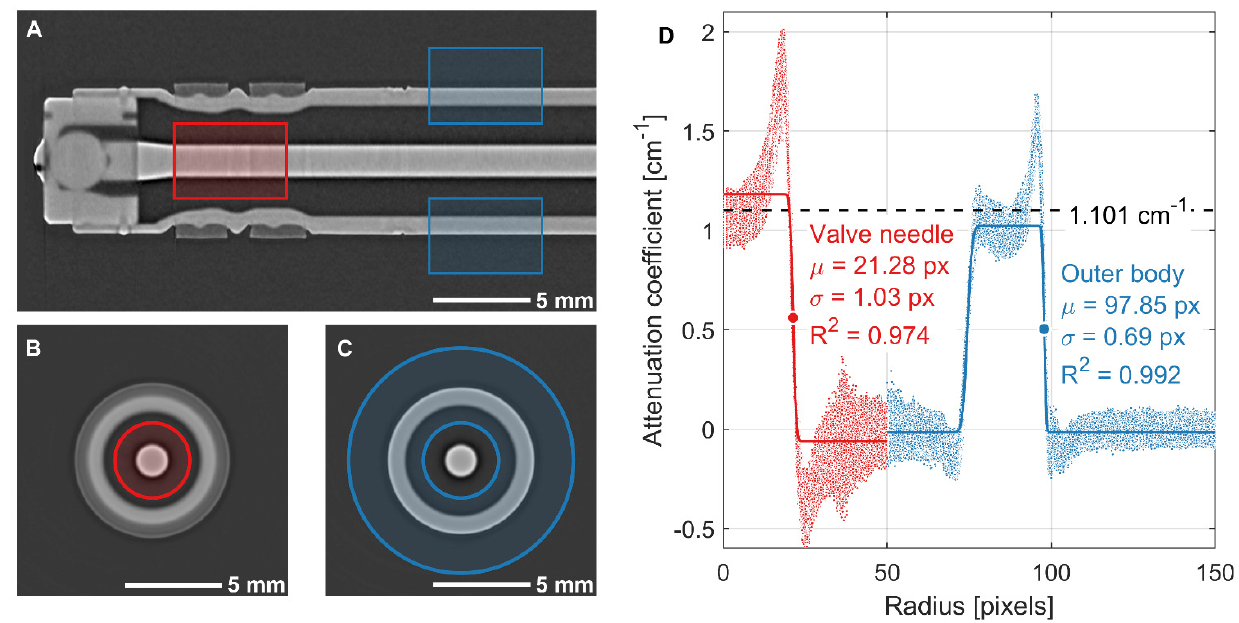
Figure 7. Process for extracting needle radius from neutron CT. Radial regions extending from the needle center were defined for both the valve needle (red) and outer body (blue) fits. ( A ) Axial and radial extent of each region overlaid on frontal slice. ( B , C ) Transverse view within each region with illustration of radial extent. ( D ) Attenuation coefficient of each voxel within each region plotted by radius with edge fits overlaid. Horizontal dashed line shows attenuation coefficient calculated from projections. Fit of outer body is used to set the image scaling based on the known outer body diameter. This scaling is used with the fit of valve needle radius to measure its size in microns.